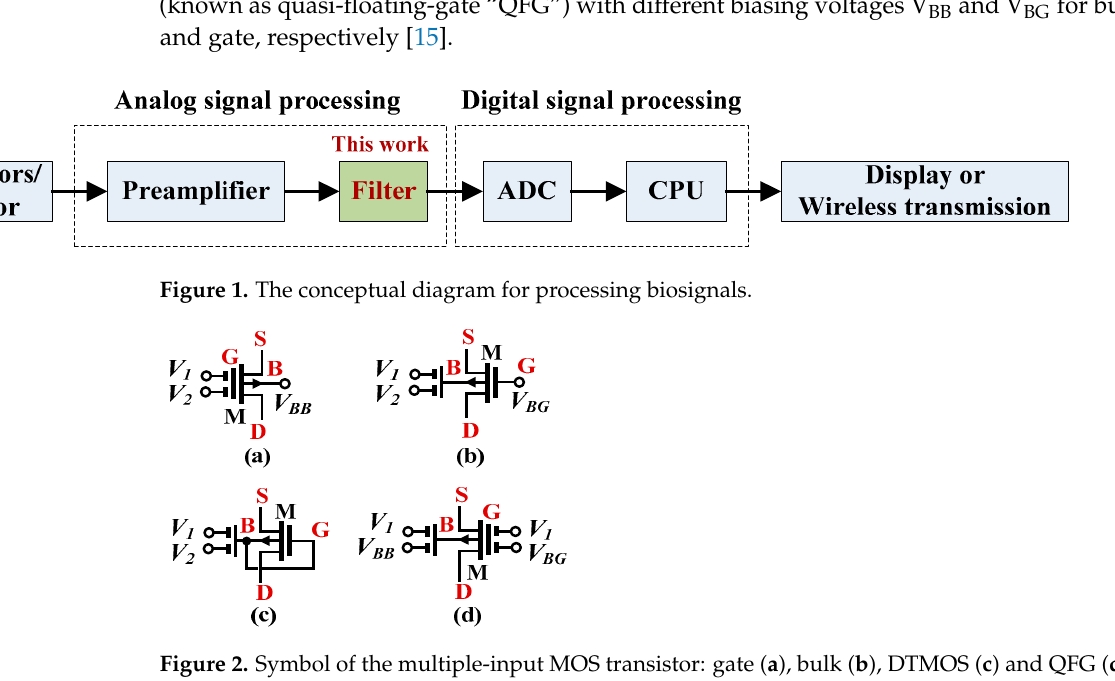
Figure 1. The conceptual diagram for processing biosignals.